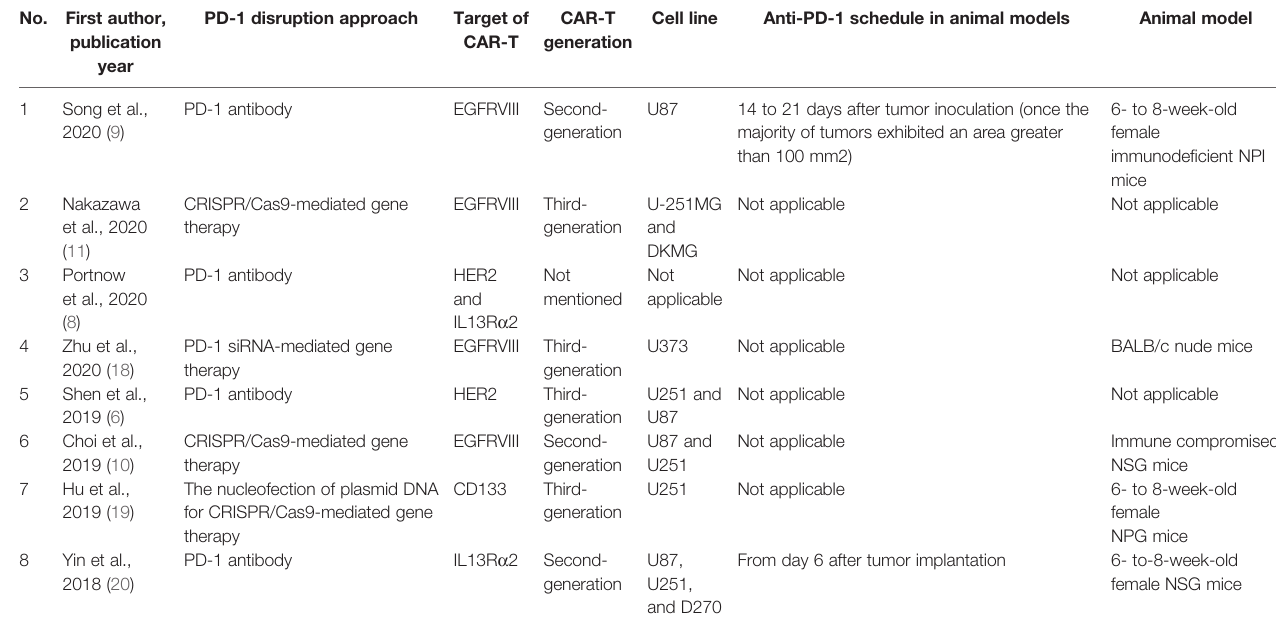
TABLE 1 | The characteristics of included studies.